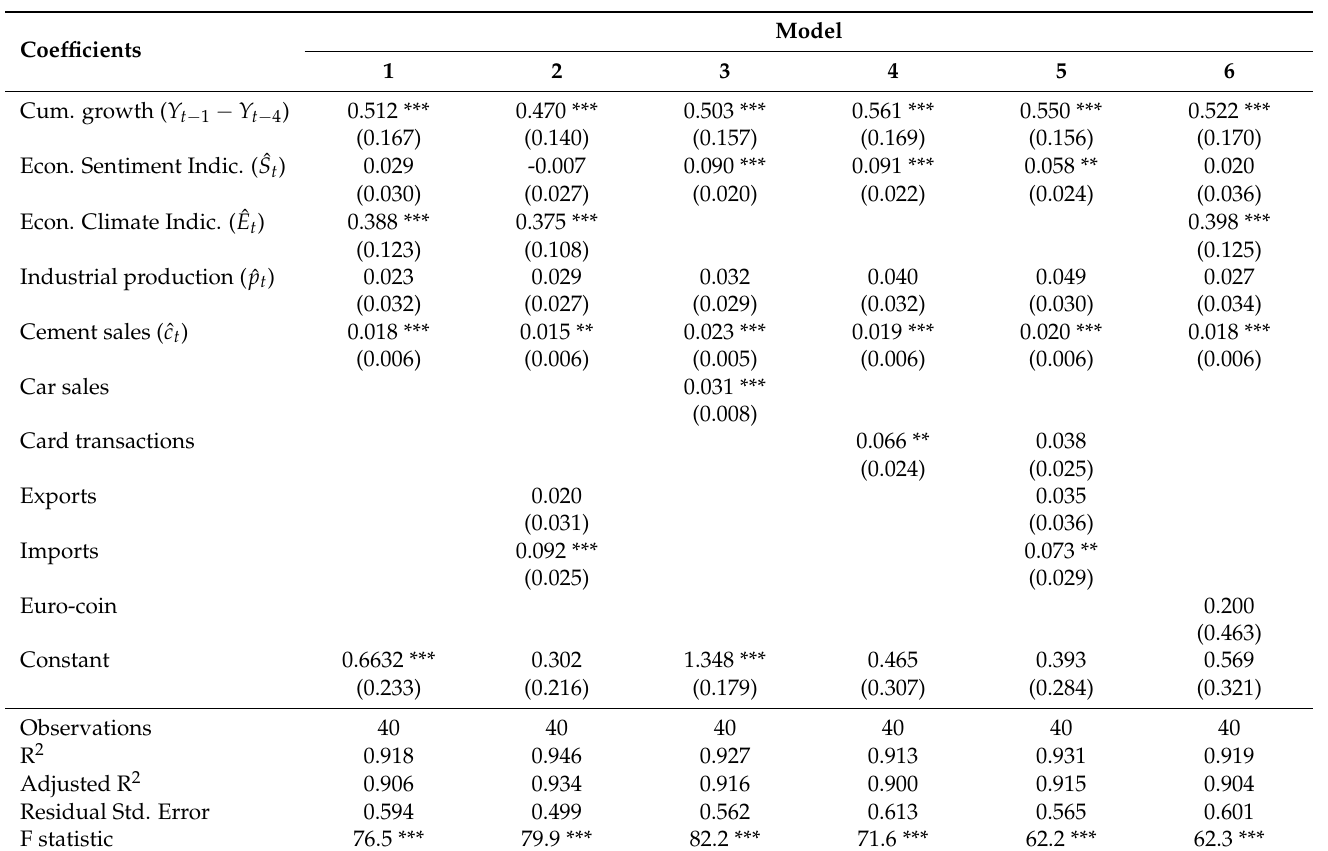
Table A5. Estimated coefficients (sub-sample